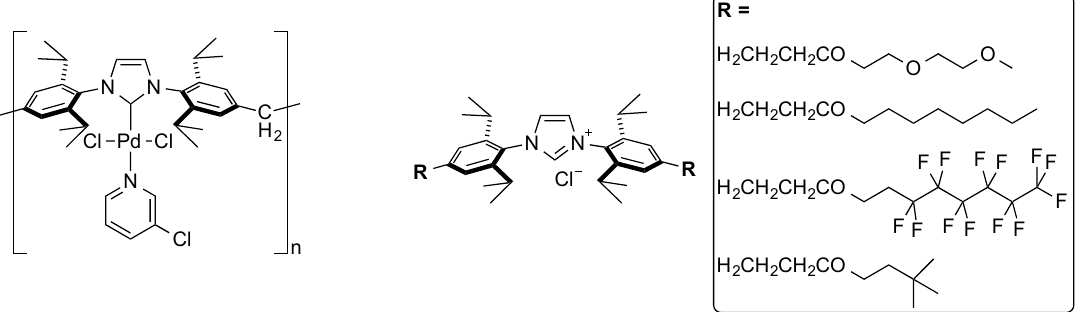
Figure 2. Polymer-modified IPr-complex (left) [68] and para -tailed IPr ligands (right) for semicontinuous reactions [70].